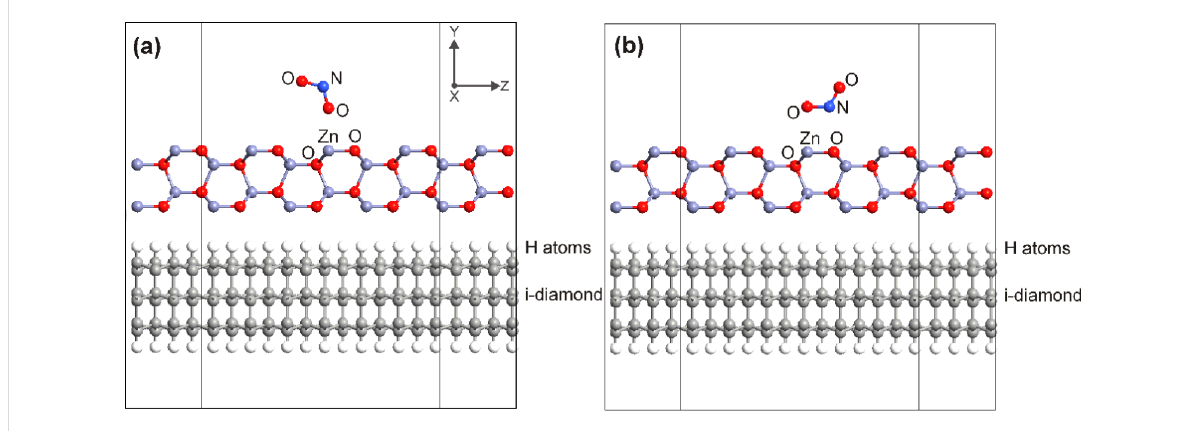
Figure 4: Simulated interaction between an NO 2 gas molecule and the non-polar hybrid ZnO NRs/NCD sensor with two different orientations of the NO 2 molecule: (a) T-shaped and (b)